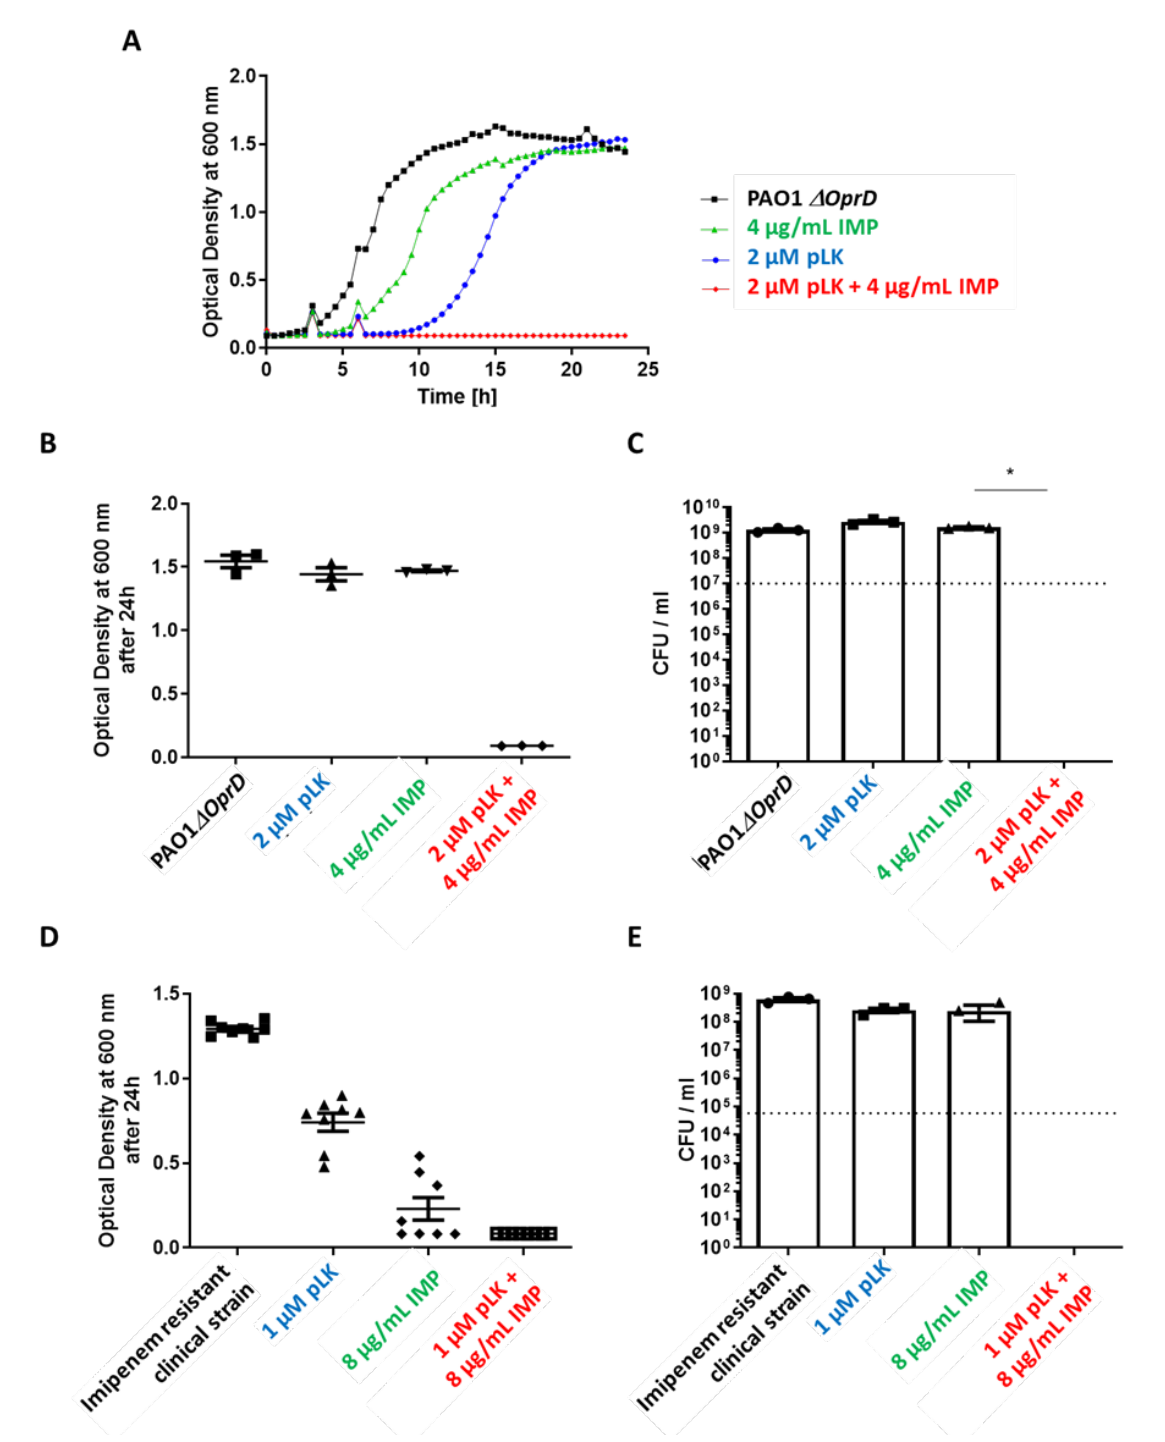
Figure 3. In vitro synergistic effect of the association between pLK and imipenem against PAO1 ∆ oprD and imipenem-resistant clinical P. aeruginosa strains. PAO1 ∆ oprD strain (1 × 10 7 /mL in exponential phase) and an imipenem-resistant isolate (1 × 10 5 /mL in exponential phase) were incubated at 37 ◦ C in Mueller–Hinton medium in the presence or absence of 2 µ M poly-L-Lysine (pLK), 4 or 8 µ g/mL imipenem (IMP) or their combination. ( A , B , D ) Bacterial growth was measured by monitoring the optical density at 600 nm after 24 h of incubation. ( C , E ) Determination of the colony forming unit (CFU)/mL was evaluated after 24 h of incubation. Values are mean ± SEM of three independent experiments. Statistical analysis was performed using the Mann–Whitney test. * p <